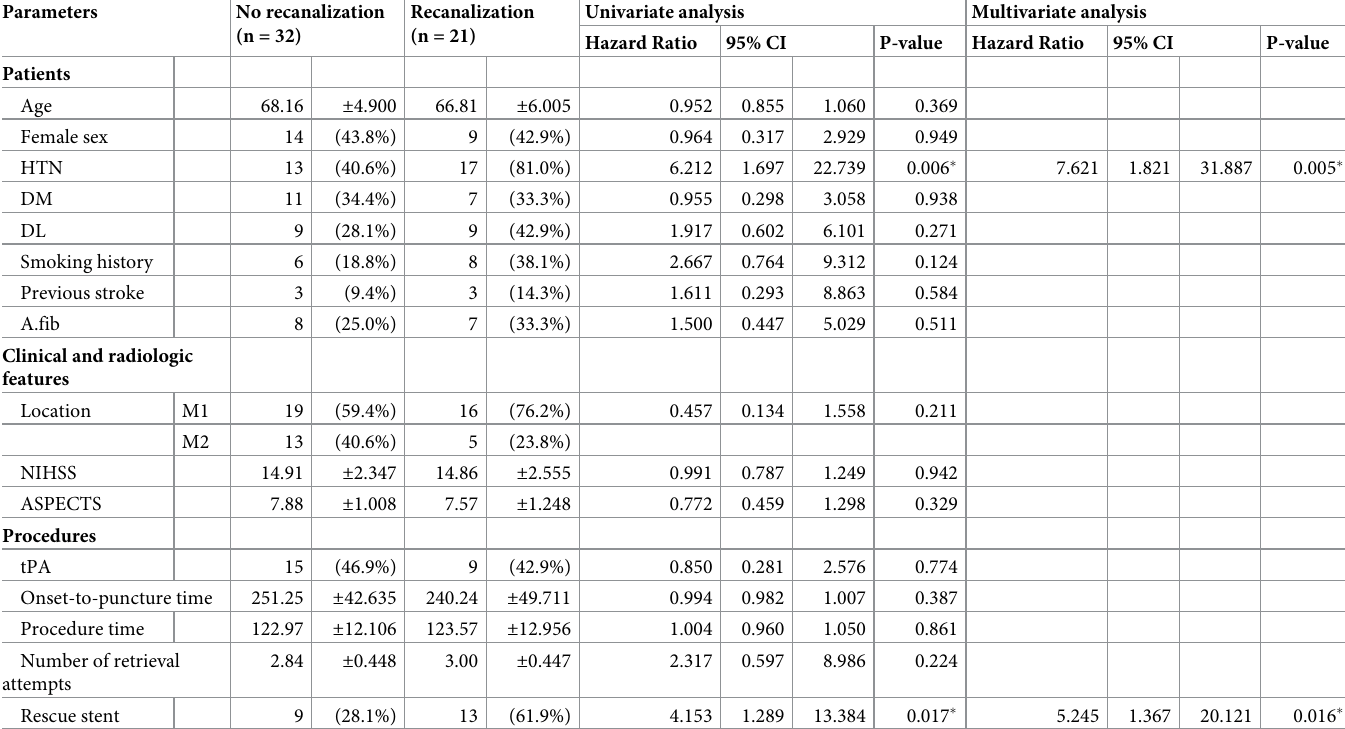
Table 3. Results of univariate and multivariate analyses for identifying factors associated with